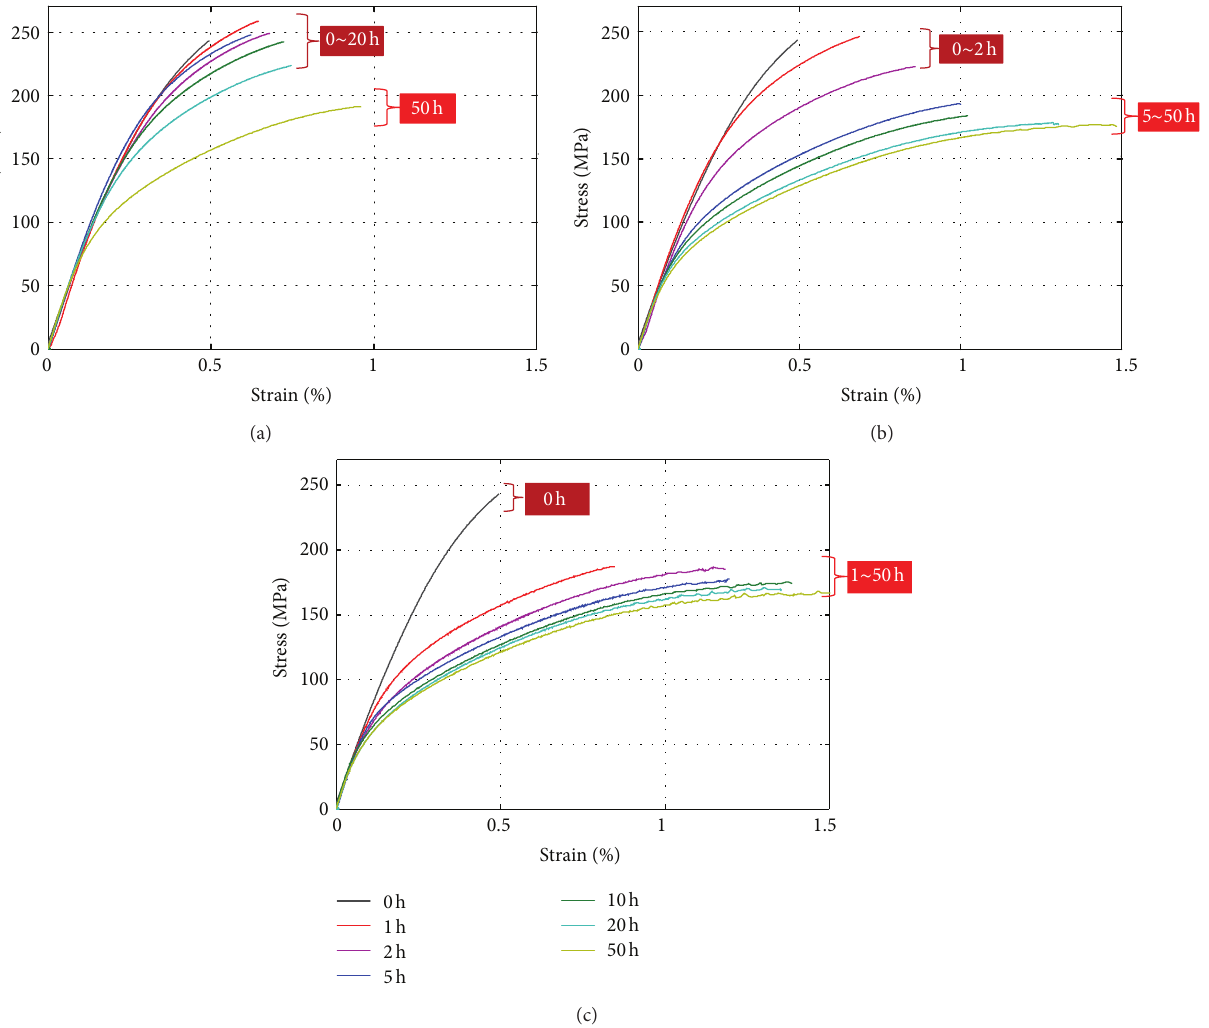
tensile strengths and elongations were obtained by the tensile test to be compared with the parameter 𝛽